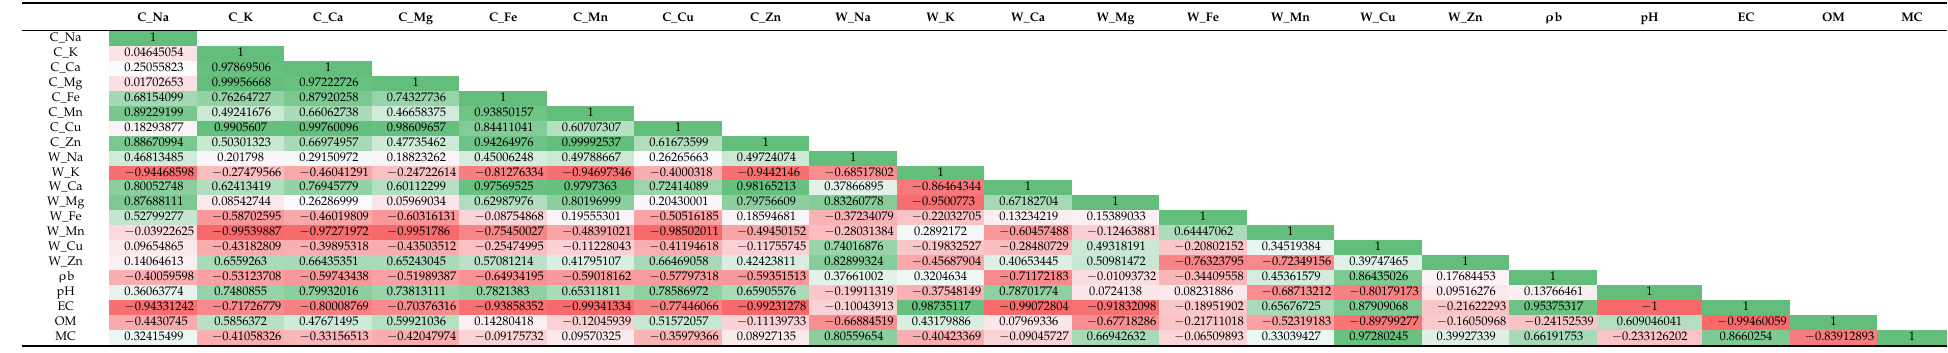
Table A7. Correlation coefficients between elemental composition nutrient content, water extractable nutrient content and physical and chemical properties of